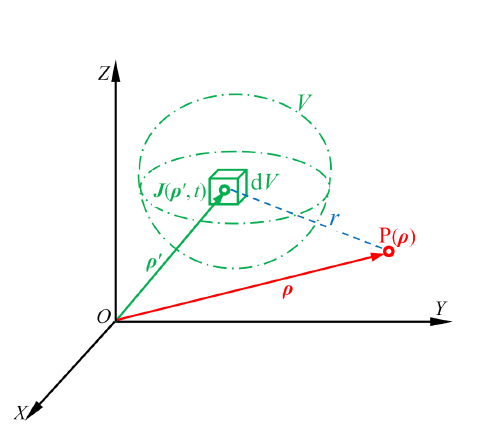
Figure 3. Geometrical quantities.